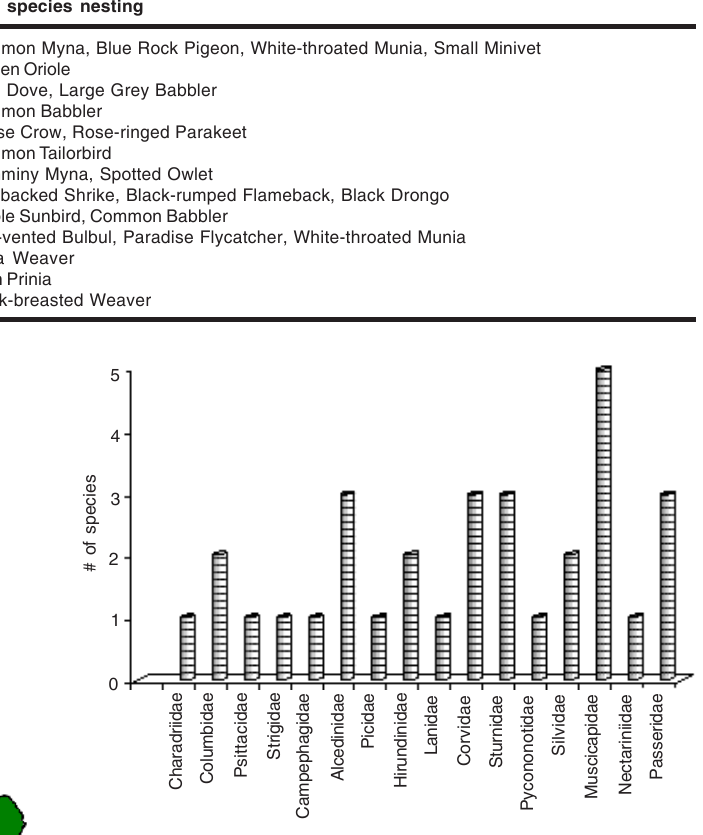
Figure 2. Family-wise number of species nesting in the Danta Forest Range,